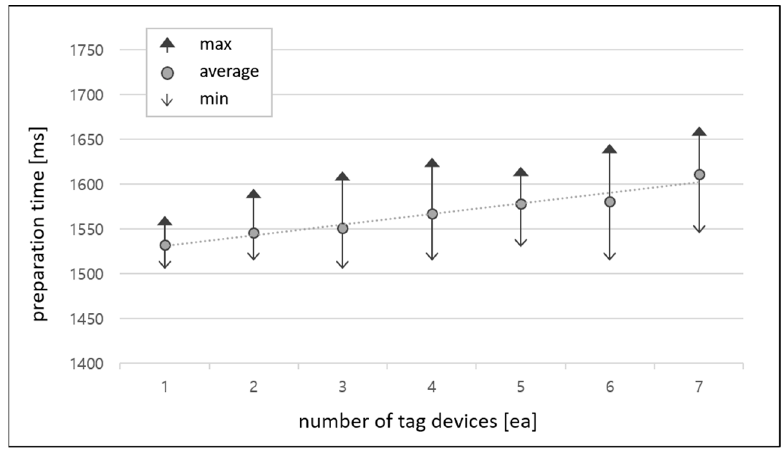
Figure 8. Preparation time of tag devices when user enters a specific indoor unit space.